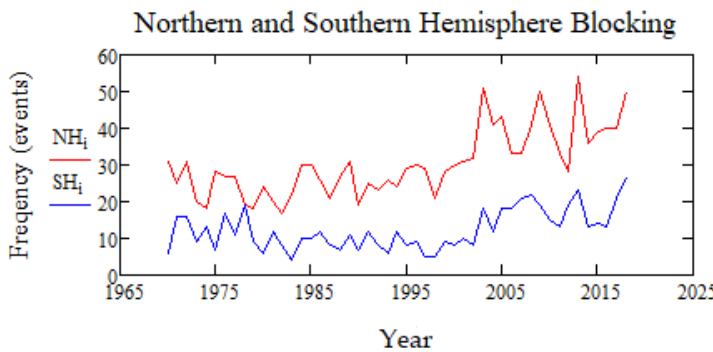
Figure 4. The annual block occurrences (ordinate) per calendar year from 1970 (abscissa) for the Northern Hemisphere (NH) (red) and the Southern Hemisphere (SH) (blue).